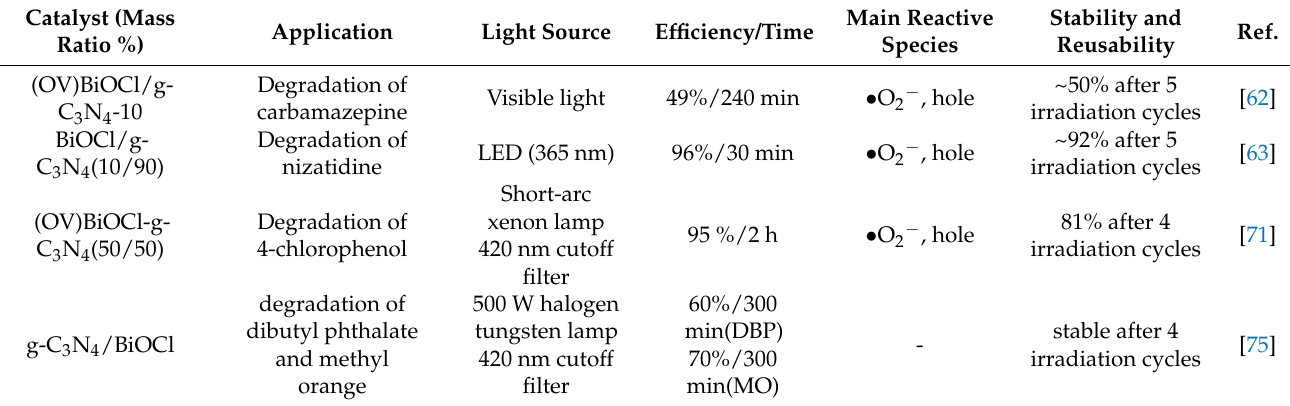
Table 5. Other applications of g-C 3 N 4 /BiOCl